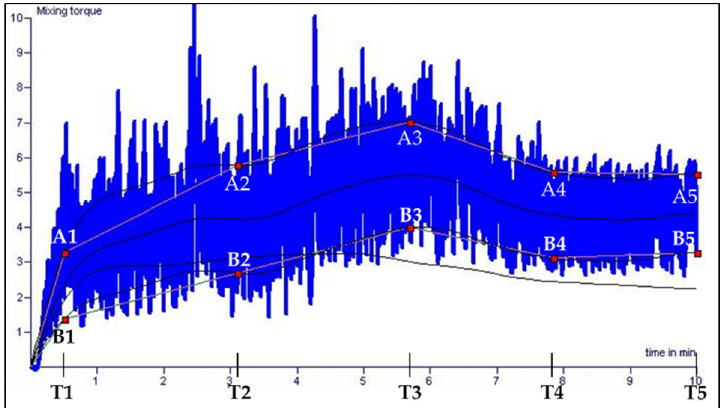
Figure 7. Mixograph curve for wheat genotype Mirakel grown in the cool year (2017).